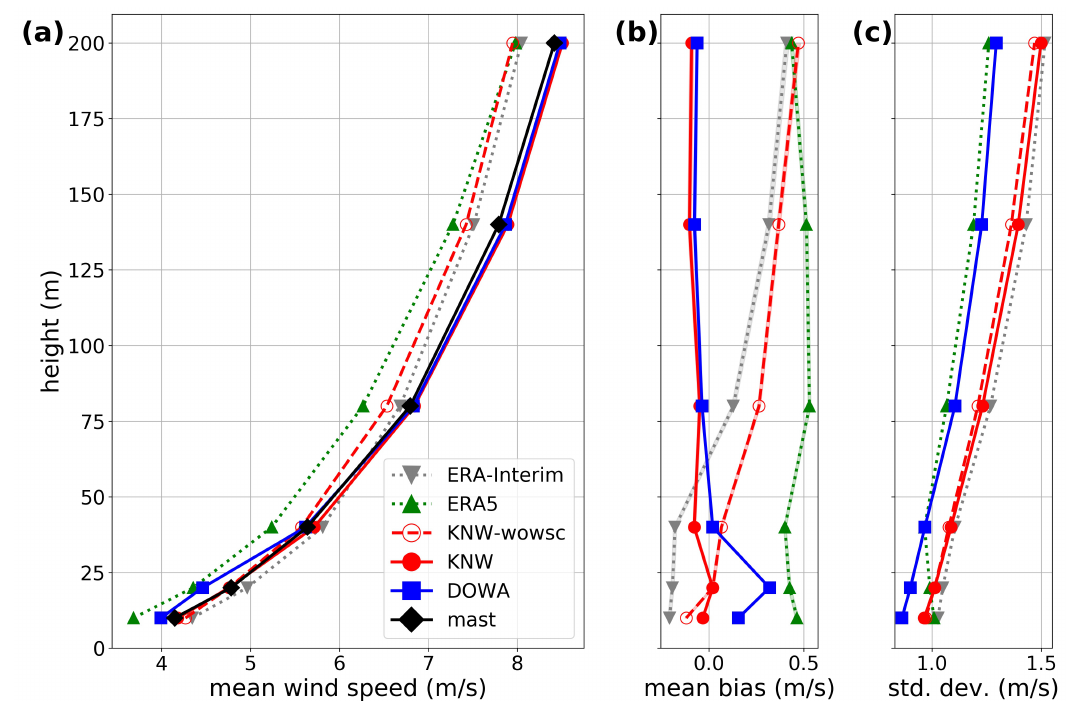
Figure 4. Height profile of ( a ) the mean wind speed, ( b ) the mean bias (measurement minus model), and ( c ) the standard deviation of the bias, showing mast measurements (black), DOWA (blue), KNW atlas (red), KNW atlas without wind shear correction (red, dashed), ERA5 (green, dotted), and ERA-Interim (gray,